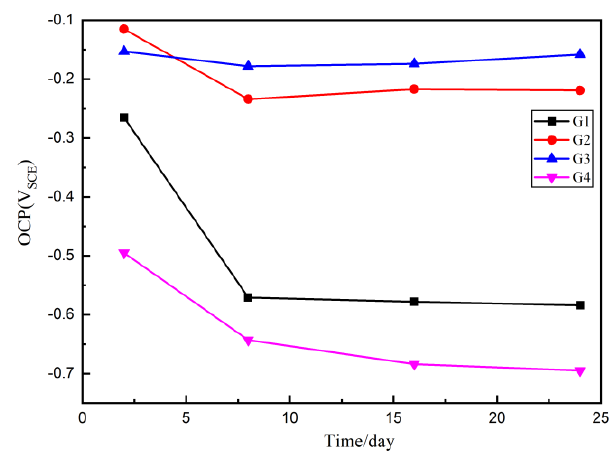
Figure 5. Each Epoxy (EP)/CeO 2 -GO coating’s open circuit potential (OCP) for immersion for 24 d.